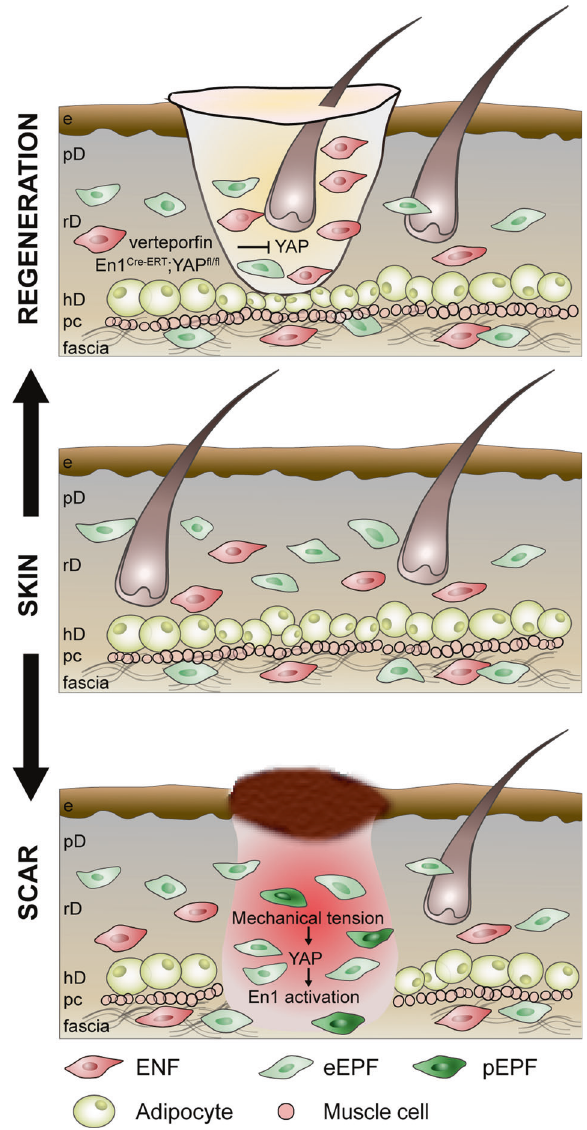
Fig. 1 Mechanical tension in wounds activates YAP signalling in ENFs, leading to postnatal activation of En1 . The conversion of ENFs to pEPFs contributes to skin scarring. Inhibition of mechanotransduction regulator YAP by chemical inhibitor vertepro fi n or pEPF-speci fi c YAP knockout prevents the conversion and leads to skin regeneration. e epidermis, pD papillary dermis, rD reticular dermis, hD hypodermis, pc panniculus carnosus, eEPF embryonic EPF, pEPF postnatal